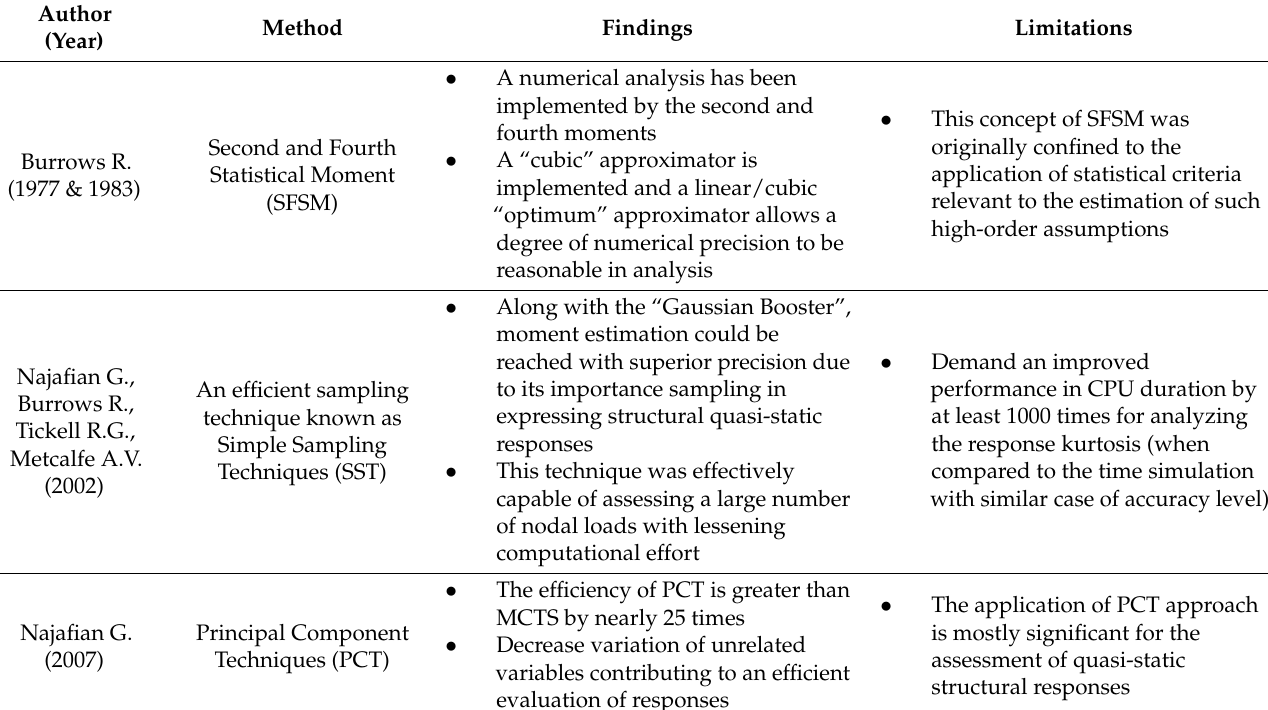
Table 1. Probability domain method in evaluating extreme